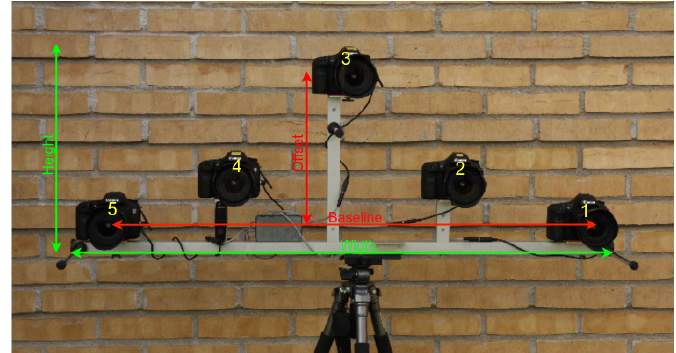
Figure 1. The camera rig used in the campaign. Outer height, 49 cm; width, 124 cm. Optical baseline, 113 cm; optical offset, 35 cm. Cameras 1, 3, 5 were Canon 7D with Sigma fixed lenses. Cameras 2, 4 were Canon 40D with Canon zoom lenses, only partially used in the study (the image shows a slightly different configuration).